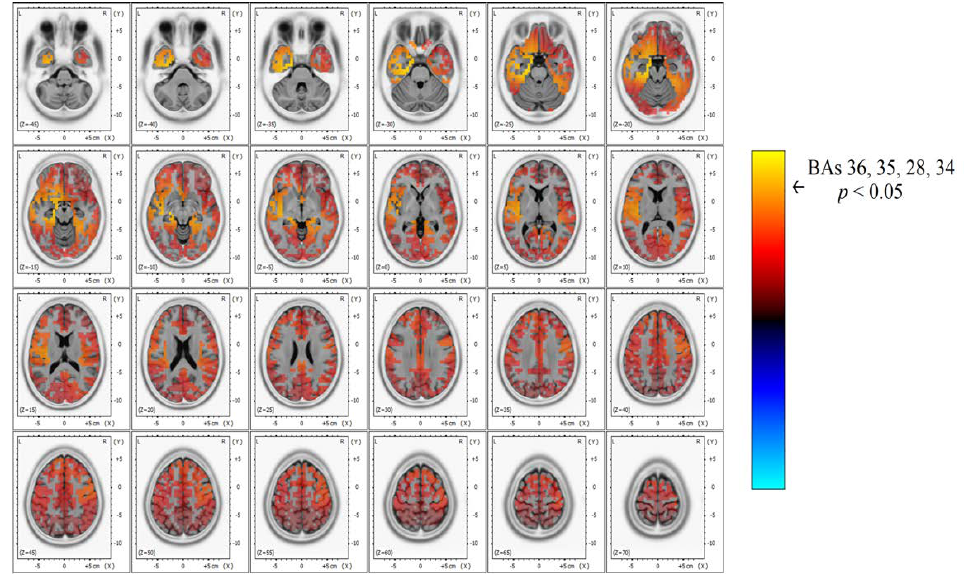
Figure 4. In-depth detail of power spectrum contrast in the beta band width, showing a significant power increase (yellow) over the left temporal area that corresponds to TEA subjects’ AH compared to TGA. Table 2. Detailed eLORETA statistics for the between group comparison (TEA vs TGA). Significant differences as well as the most prominent modifications are reported for each frequency band.